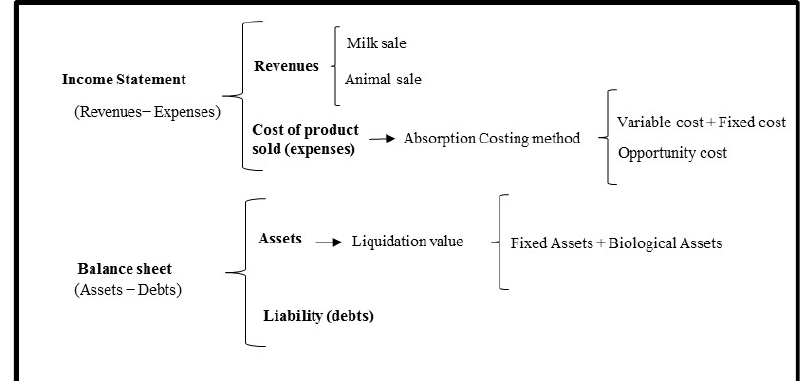
Figure 3. Accounting Analysis framework for Dairy Activity.